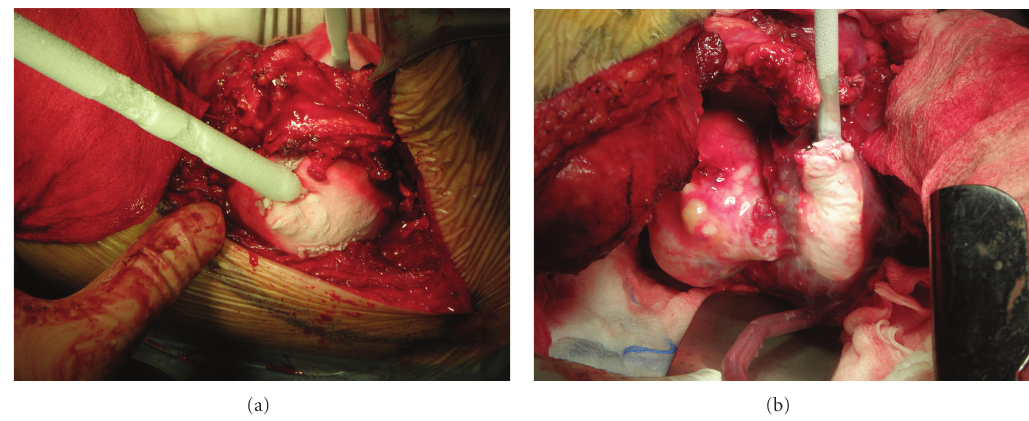
Figure 4: The second stage of the procedure. The tumour had 3 lobes and was treated with liquid nitrogen ( − 17 ◦ C for 15min/lobe). The equipment used was Candela CS5 (Spembly